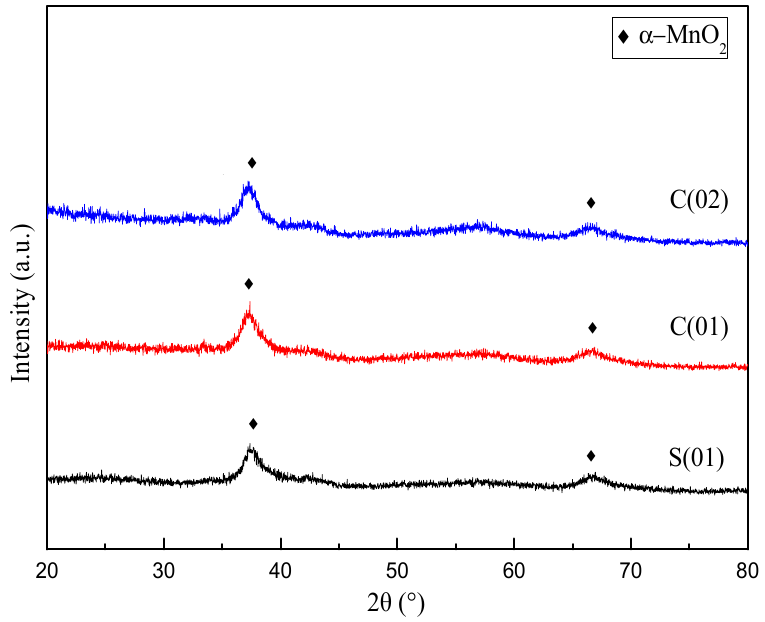
Figure 4. XRD patterns of MnO 2 prepared at different operating conditions (Note: Please refer to the reactor Ref. # in Table 2).